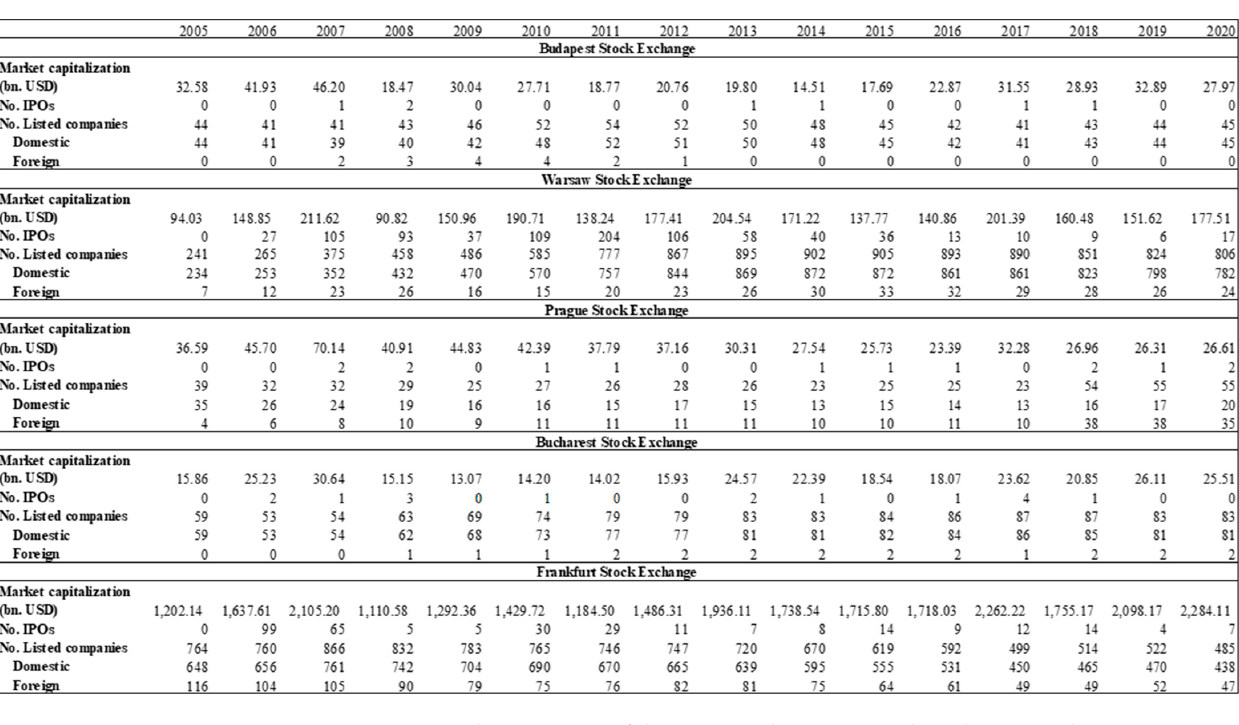
Figure A1. Main Characteristics of the CEEC and German Stock Exchange Markets.